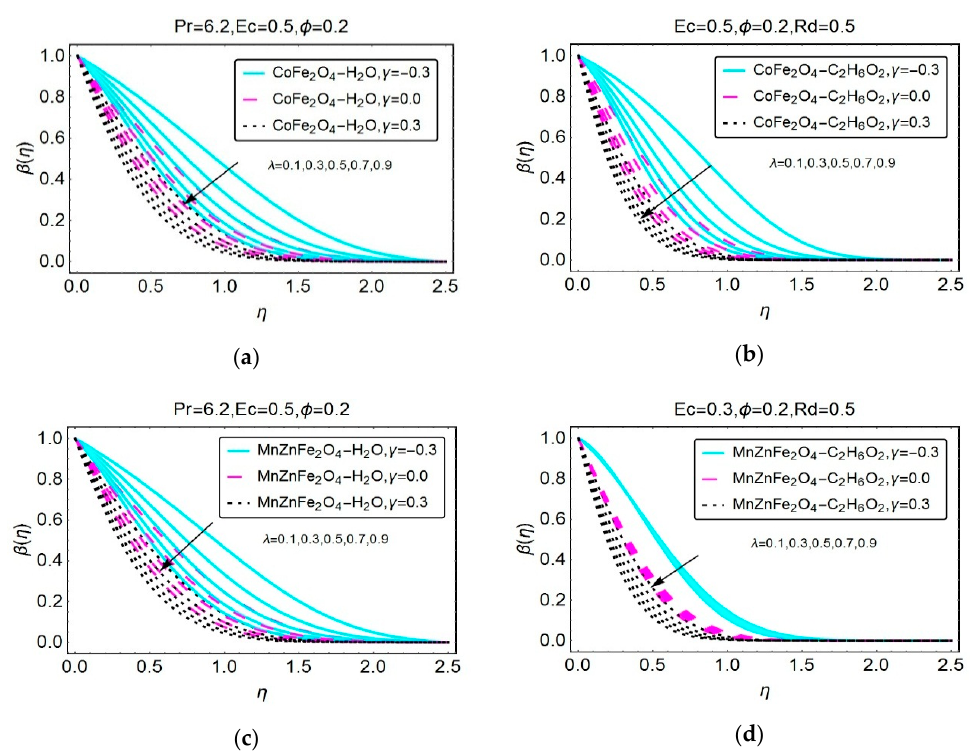
Figure 3. Alterations in the temperature distributions for ( a ) CoFe 2 O 4 − H 2 O; ( b ) CoFe 2 O 4 − C 2 H 6 O 2 ; ( c ) MnZnFe 2 O 4 − H 2 O; ( d ) MnZnFe 2 O 4 − C 2 H 6 O 2 nanofluids by varying λ